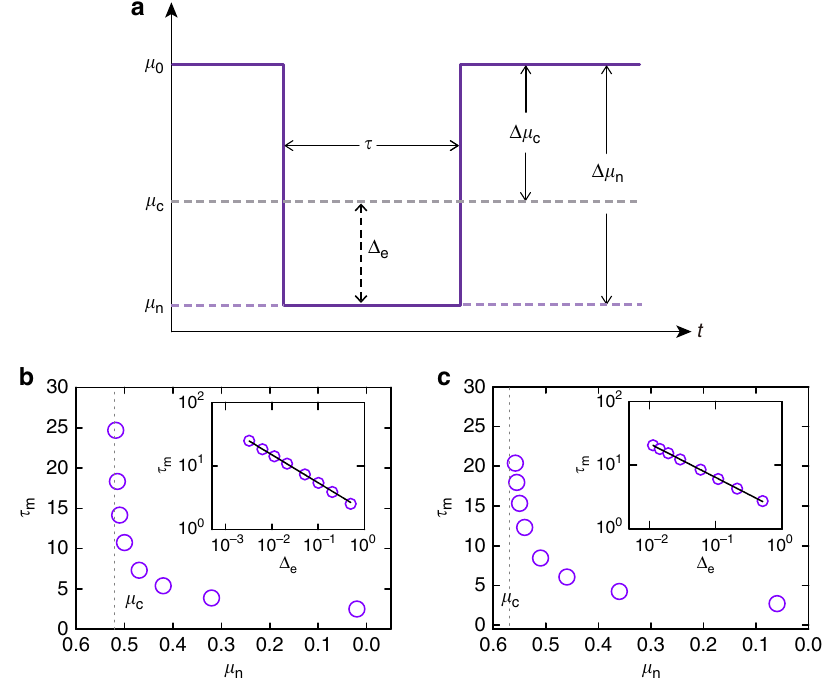
Figure 2 | Relationship between edge control strength and minimal control time. For the T-cell network, ( a ) an inverted rectangular control signal of duration t and amplitude D m n ¼ m n (cid:3) m 0 j j , where m 0 is the original parameter value and m n is the control parameter value. A saddle-node bifurcation occurs for m ¼ m c , so D e ¼ m c (cid:3) m n is the excessive amount of the parameter change over the critical value m c . ( b , c ) Minimal control time t m versus m n , where parameter control is applied to the activation edge from node ‘S1P’ to node ‘PDGFR’ and to the inhibitory edge from ‘DISC’ to ‘MCL1’, respectively. These four nodes are indicated with the solid black circles in Fig. 1a. The corresponding plots on a logarithmic scale in the insets of ( b , c ) suggest a power-law scaling behaviour between t m and D e (equation (2)). The fitted power-law scaling exponents are b E (cid:3) 0.44 and (cid:3) 0.55, respectively, for ( b , c